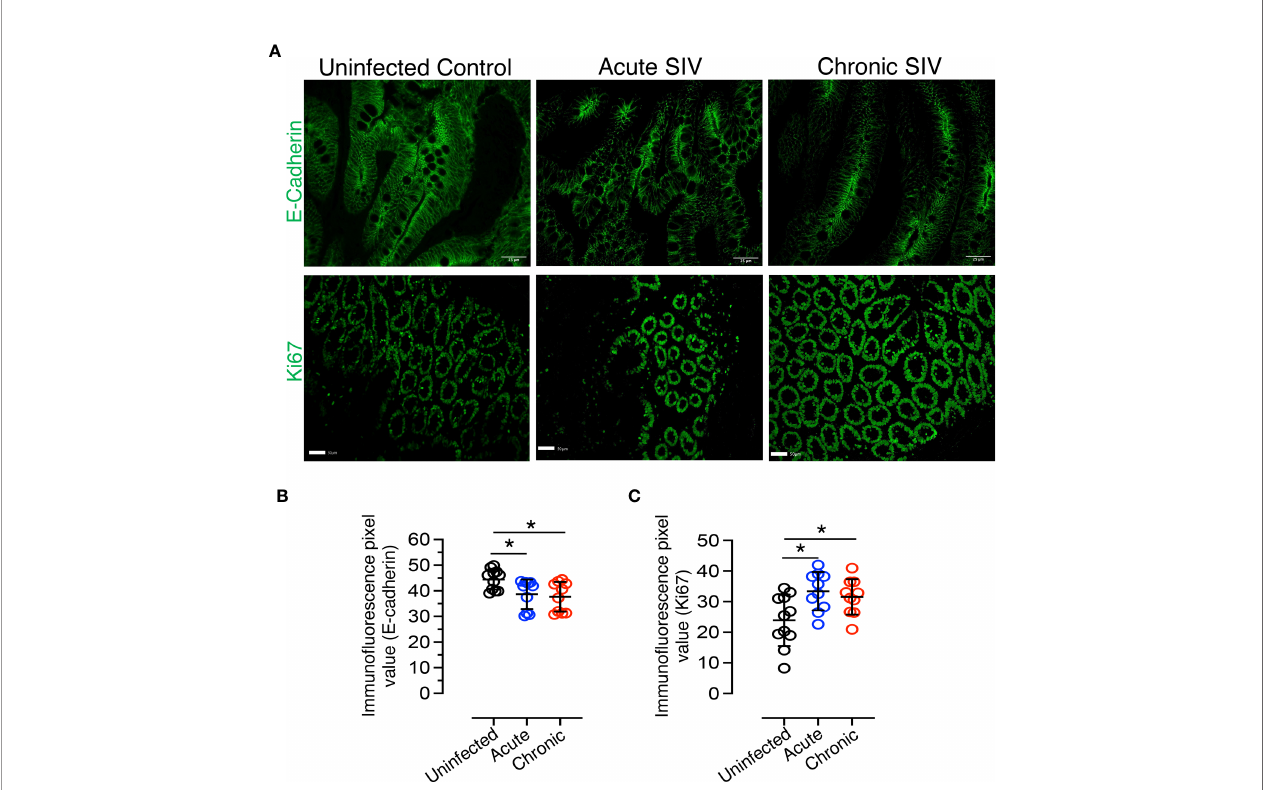
FIGURE 4 | Reduced E-cadherin and increased proliferation markers detected during SIV infection in RhM jejunum tissue. (A) Top panel: Representative E-cadherin expression in normal uninfected (macaque number GT20), acutely (macaque M992), and chronically (DE50) SIV-infected RhMs . Bottom panel: Representative Ki67+ staining is shown for normal (macaque GT20), acutely (M992), and chronically (DE50) SIV-infected RhMs . Scatter plots of E-cadherin (B) and Ki67+ (C) immuno fl uorescence pixel values for normal (n=11), acutely (n=10), and chronically (n=10) SIV-infected RhMs . The expression intensity of E-cadherin and Ki67 protein was quanti fi ed in 19-20 randomly selected fi elds/region of interest (ROI) for each animal and the intensity in each selected fi eld/ROI was quanti fi ed. Each point in the scatter plot represents the average of quanti fi ed intensities for relevant cellular markers of each animal. The larger horizontal line denotes the mean frequencies (± standard deviation) of each category. Statistically signi fi cant differences of E-cadherin+ or Ki67+ staining among SIV-infected and uninfected RhMs are shown as analyzed with ANOVA followed by Tukey-Kramer multiple comparison (* p < 0.05). A p -value < 0.05 was considered signi fi